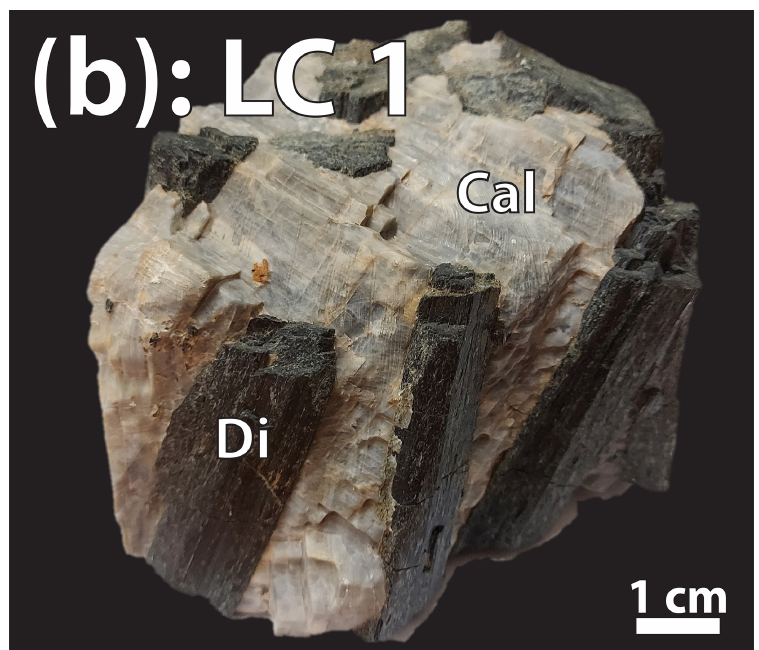
Figure C3. Large image of sample ME1 from Mt Elliott, Mt Isa region, Australia. Large images shows sample location and inset shows hand sample. Di: diopside; Scp: scapolite; Cal: calcite; Mag: magnetite.